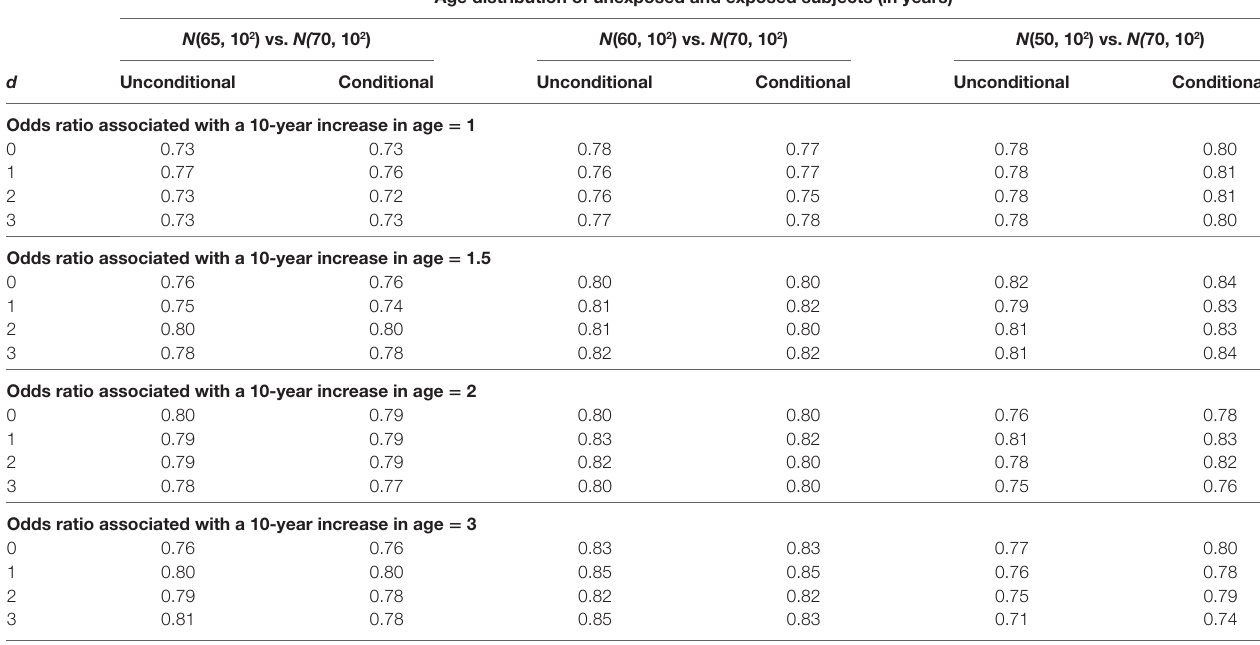
Table 2 | Power of unconditional and conditional logistic regression models.